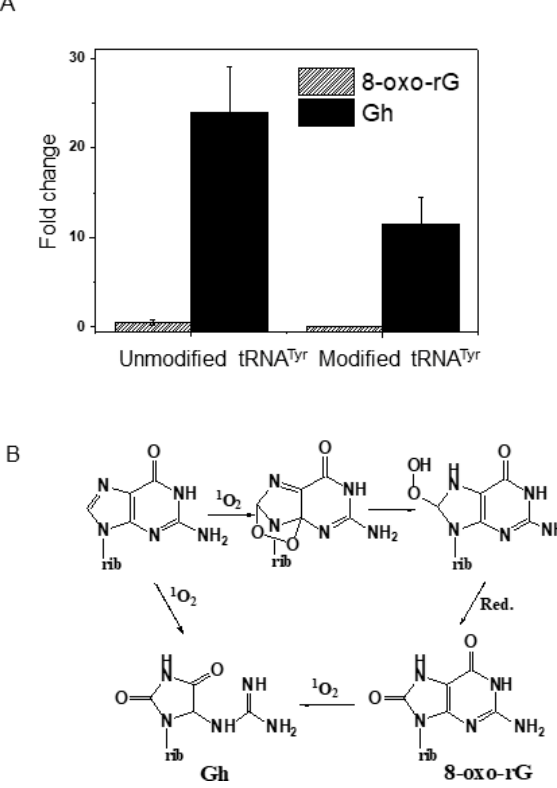
Figure 3. Guanosine oxidation levels in UV-exposed tRNA compared to unexposed samples. ( A ) An unmodified (in vitro transcript) and modified tRNA Tyr were exposed to UVA in the presence of photosensitizer and fold change was computed by taking the ratio of the peak areas of guanosine oxidation products in UVA-exposed samples against that of unexposed samples. The signal for each oxidation product was normalized against the canonical guanosine in each sample. ( B ) Schematic flow of guanosine oxidation into 8-oxo-rG and guanidinohydantoin (Gh).